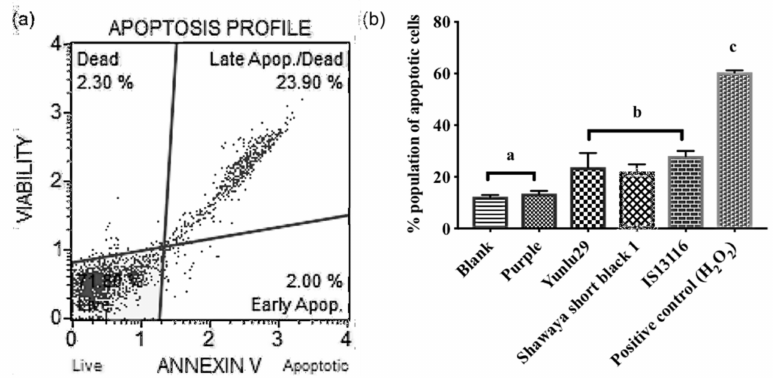
Figure 3. ( a ) Yunlu29 Muse plot of apoptosis induction ( b ) Proportion of pro-apoptotic activity